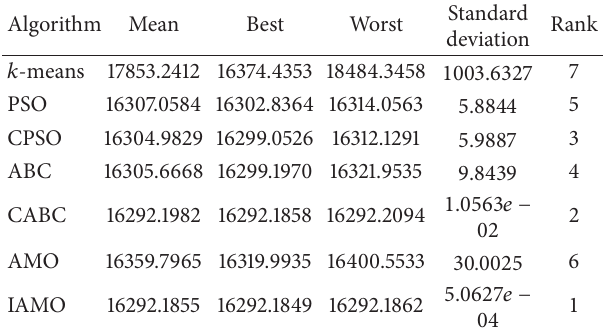
Table 5: Results obtained by the algorithms for 20 different runs on wine data.